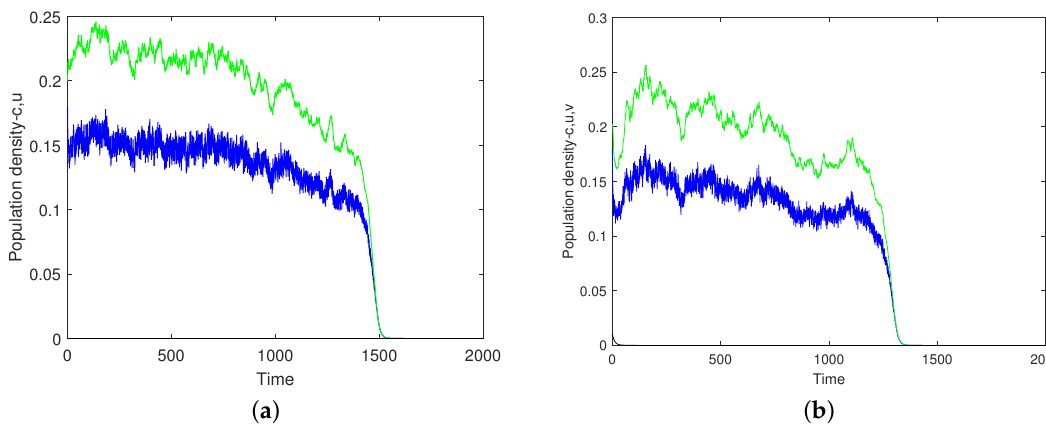
Figure 12. Phytoplankton density (green) and the concentration of oxygen (blue) vs. time obtained for parameters A Q = 0.94, A D = 0.3, w A = 2 · 10 − 5 , c 1 Q = 0.75, c 1 D = 0.1 and w C = 10 − 6 . ( a , b ) show two simulation runs obtained for the same parameters and the initial conditions.